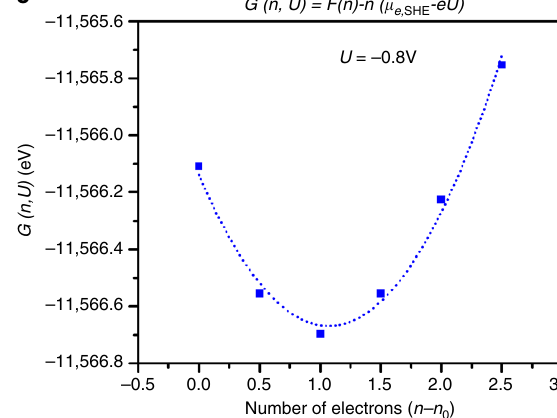
Fig. 2 Behavior of free energy and grand canonical potential as a function of the number of electrons. a The free energies as a function of number of electrons show a nearly linear relationship. b The relation between free energy and number of electrons becomes quadratic when the energy contribution of each electron at SHE are subtracted from total free energy. The quadratic dependence allows the optimum number of electrons within the system. c Minimization of free energy as a function of number of electron when an external potential is applied to the system. The free energy minimum is shifted toward higher electron numbers when voltage applied, ensuring that the reaction progresses in the forward direction. The blue dots represent DFT energies while the dash curve refers polynomial 2nd order fi tting. Our calculated rates use cubic splines to fi t the